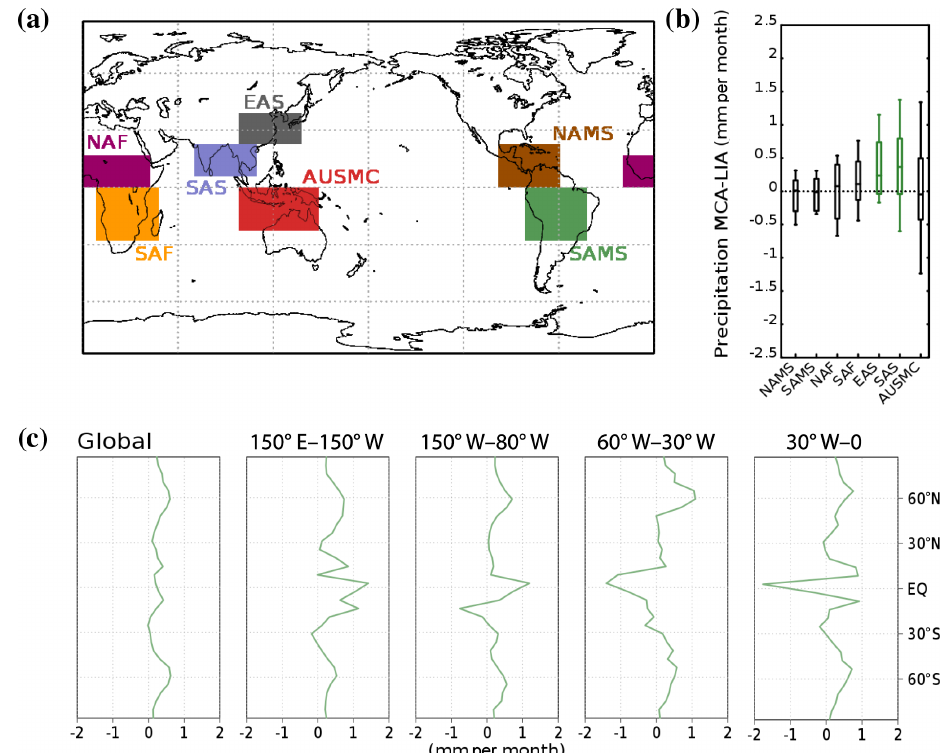
Figure 12. (a) Areas considered in the analysis of monsoon domains: North American monsoon system (NAMS), South American monsoon system (SAMS), the northern African (NAF), southern African (SAF), East Asian summer (EAS), South Asian summer (SAS) monsoons, and the Australian–Maritime continent (AUSMC). (b) Precipitation differences for MCA–LIA over the monsoon domains. Box and whisker plots show the 10th, 25th, 50th, 75th, and 90th percentiles of simulations included in Table 1. Domains with significant changes ( p < 0 . 05) have been highlighted in green. (c) Zonal mean of precipitation for the composite MCA–LIA for the whole globe and for bands of 150 ◦ E–